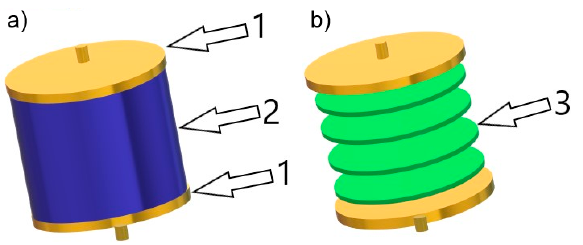
Figure 7. Geometry of the system ( a ) and division of the discharge space with “virtual” surfaces ( b ). 1—electrodes; 2—juice; 3—“virtual” surfaces dividing the discharge area.